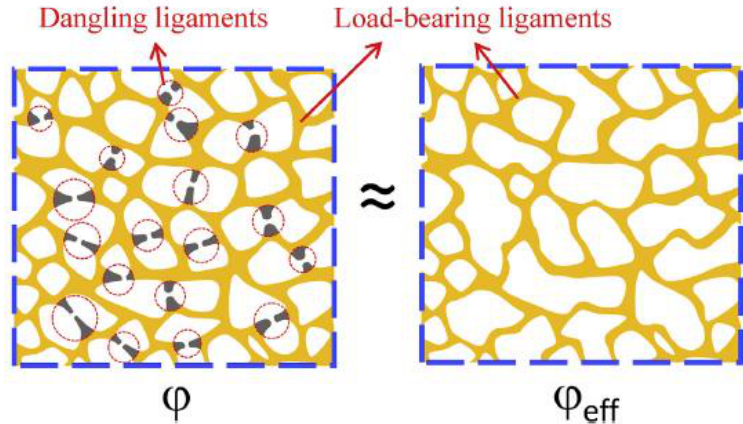
Figure 6. Schematic of removing dangling ligaments from the initial structure, results in structure with all load-bearing ligaments at the e ff ective solid fraction ϕ ef f , by [78]. Reprinted from [78] with with all load-bearing ligaments at the effective solid fraction 𝜑 𝑒𝑓𝑓 , by [78]. Reprinted from [78] with permission from permission from Elsevier.